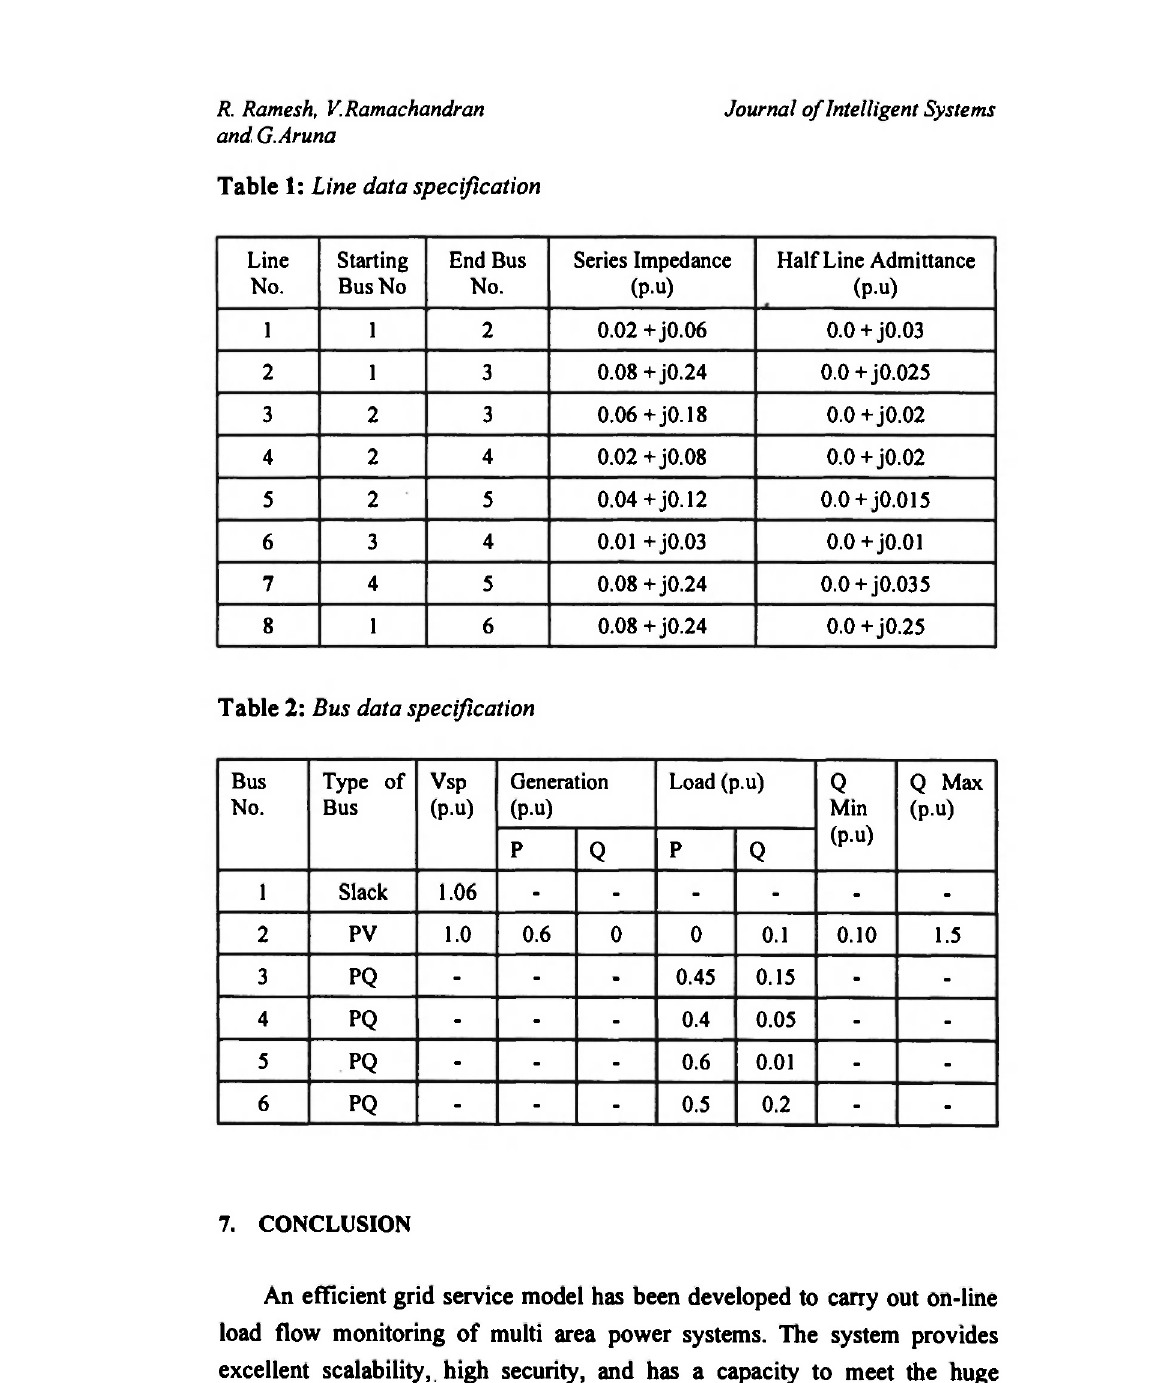
Table 1: Line data specification